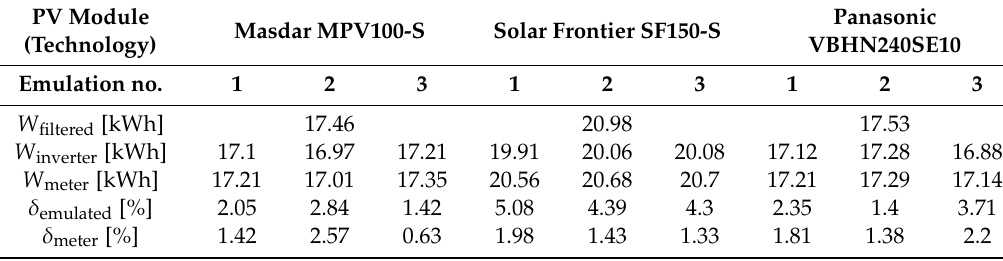
Table 6. Results of fast PV power emulation of the 6 kW PV plant for 28 March